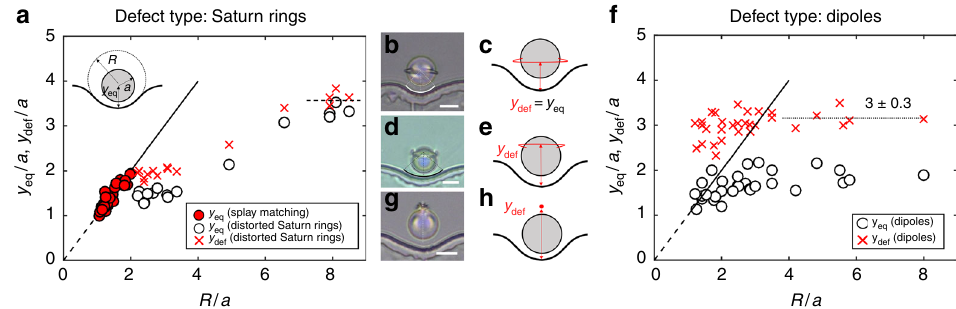
Fig. 3 Particle-wavy wall interactions mechanisms. y eq and y def measure the equilibrium distance relative to the bottom of the wells of the wavy wall for the COM of the colloid and the defect. a Filled red circles denote splay matching cases, where the Saturn ring sits at the equatorial position ( y def / a = y eq / a ). Crosses denote location of distorted Saturn rings, y def / a > y eq / a . Open circles indicate the height of the center of mass (COM) of the colloid. The dotted line denotes fl at wall limit. Inset: Schematic of system geometry. b , c Experimental bright fi eld microscopy image and schematic of splay matching. d , e Experimental bright fi eld microscopy image and schematic of distorted Saturn ring. f Heights of the center of mass (COM, open circles) and hedgehog defects (crosses) of the colloid with dipole defects. g , h Experimental bright fi eld microscopy image and schematic of dipoles and their defects. The